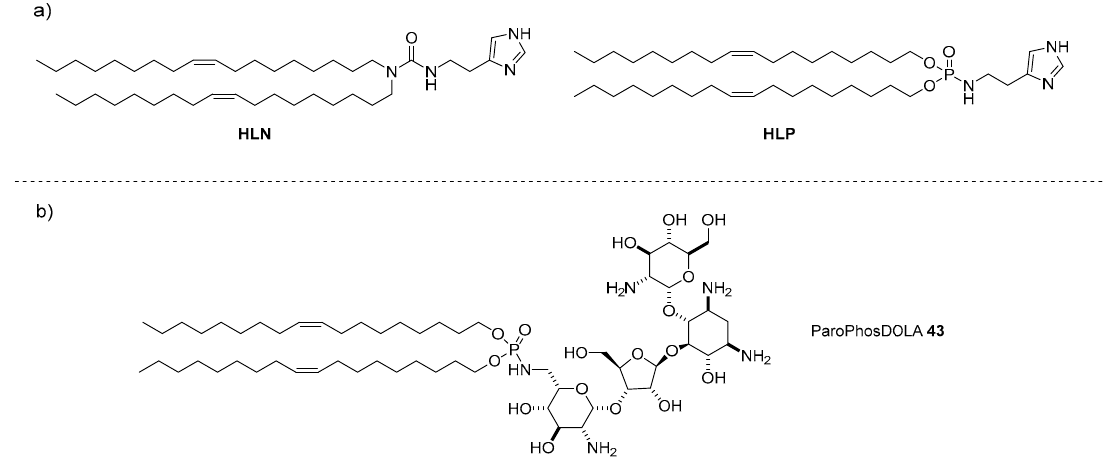
Figure 12. Structures of ( a ) nitrogen-based helper lipid HLN and phosphorous-based helper lipid HLP , and ( b ) ParoPhosDOLA lipid 43